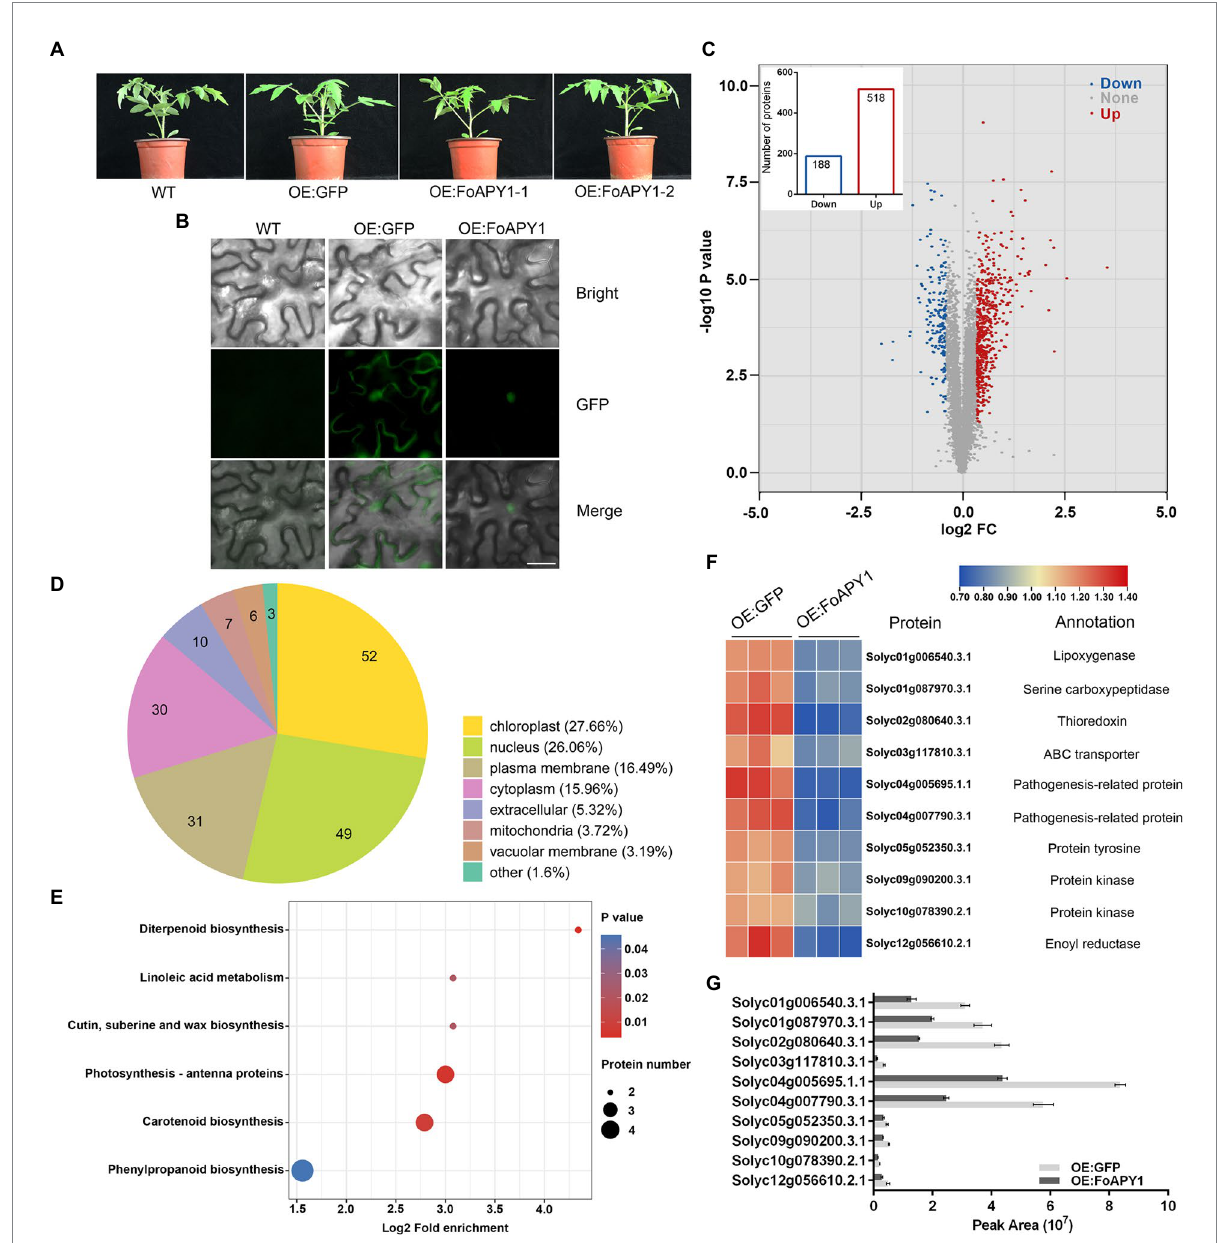
FIGURE 6 Proteomic analysis of FoAPY1 gene transgenic tomato plants. (A) Morphology of WT, OE:GFP and OE:FoAPY1 tomato plants. All the plants were grown at 25 ° C for 4 weeks in an artificially controlled growth chamber, and images were collected. (B) Subcellular localization of FoAPY1 protein fused with a GFP tag in tomato ( Solanum lycopersicum ). GFP alone was used as a negative control in this experiment. Bars = 20 μ m. (C) Volcano plot of DAPs identified in the OE:GFP and OE:FoAPY1-GFP plant groups. The blue dots represent the downregulated proteins, the red dots represent the upregulated proteins, and the gray dots represent the proteins with no significant change in the two groups. The number of DAPs is shown in the histogram. (D) Subcellular localization classification of the downregulated proteins was predicted. (E) KEGG pathway enrichment analysis of downregulated proteins. All the proteins were enriched in six pathways. The x-axis represents the enrichment factor; the y-axis represents the main KEGG pathways. The point size indicates the number of target genes. (F) Expression level analysis of selected DAPs in OE:GFP and OE:FoAPY1 tomato plants. The proteins are displayed in different colors. Protein abundance levels are shown in a colour gradient from low to high as a legend. Each heatmap from left to right shows OE:GFP and OE:FoAPY1. The annotation of each protein is shown on the right of the heatmap. (G) Ten selected proteins in the proteome of different groups measured by PRM. The peak area represents the protein abundance in each tomato plant